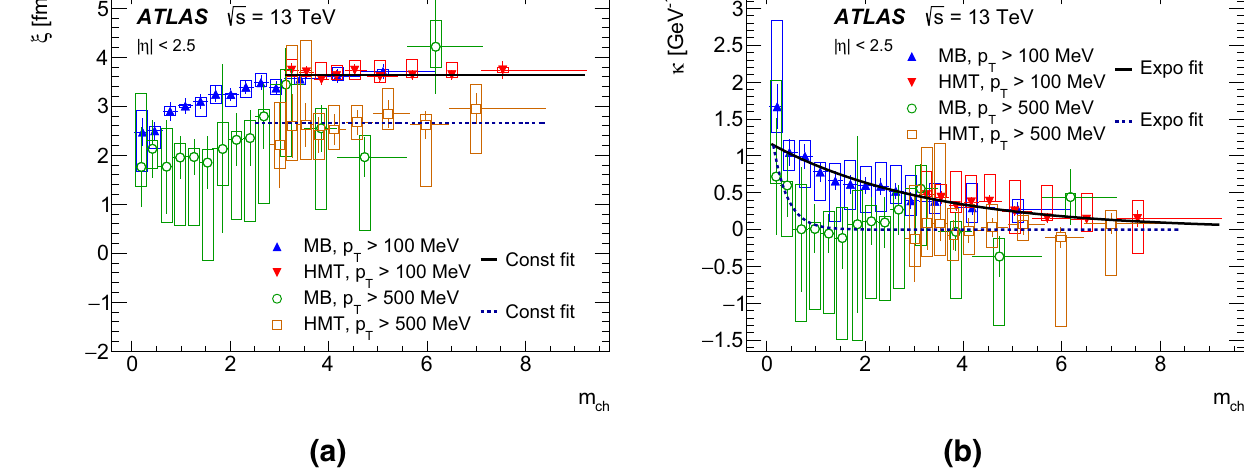
blue dashed curves represent the saturated value of the parameter ξ for m ch > 3 . 0 for tracks with p T > 100 MeV and for m ch > 2 . 8 for tracks with p T > 500 MeV, respectively. b The black solid and blue dashed curves represent the exponential fit to the parameter κ for tracks with p T > 100 MeV and for tracks with p T > 500 MeV,